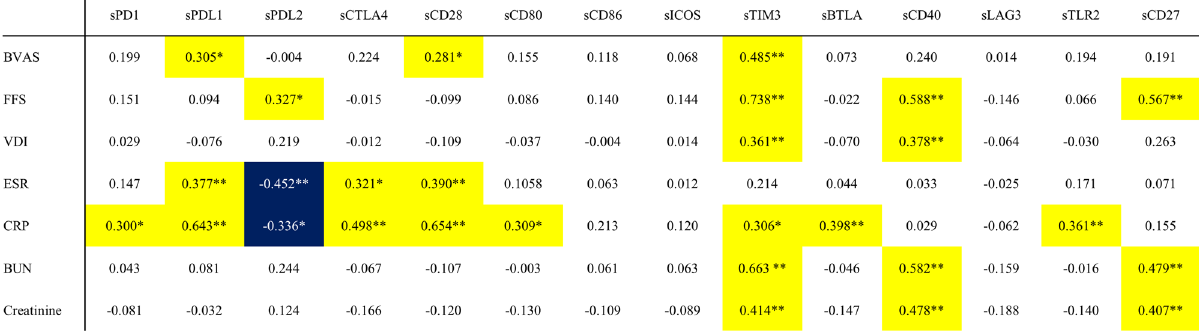
Figure 1. Pearson correlation analysis between serum soluble checkpoint molecule concentrations and disease activity markers of AAV in patients with active AAV. Correlations between disease activity markers and the concentrations of soluble checkpoint molecules are shown. Yellow: positive correlation; blue: negative correlation. * P < 0.05, ** P < 0.01. sPD Soluble programmed cell death, sPD-L Soluble programmed cell death ligand, sCTLA-4 Soluble cytotoxic T-lymphocyte antigen 4, sCD Soluble cluster of differentiation, sICOS Soluble inducible T-cell costimulatory, sTIM-3 Soluble T-cell immunoglobulin and mucin-domain containing-3, sBTLA Soluble B- and T-lymphocyte attenuator, sLAG-3 Soluble lymphocyte-activation gene 3, sTLR-2 Soluble toll-like receptor 2, BVAS Birmingham vasculitis activity score, FFS Five-factor score, VDI Vasculitis damage index, ESR Erythrocyte sedimentation rate, CRP C-reactive protein, BUN Blood urea